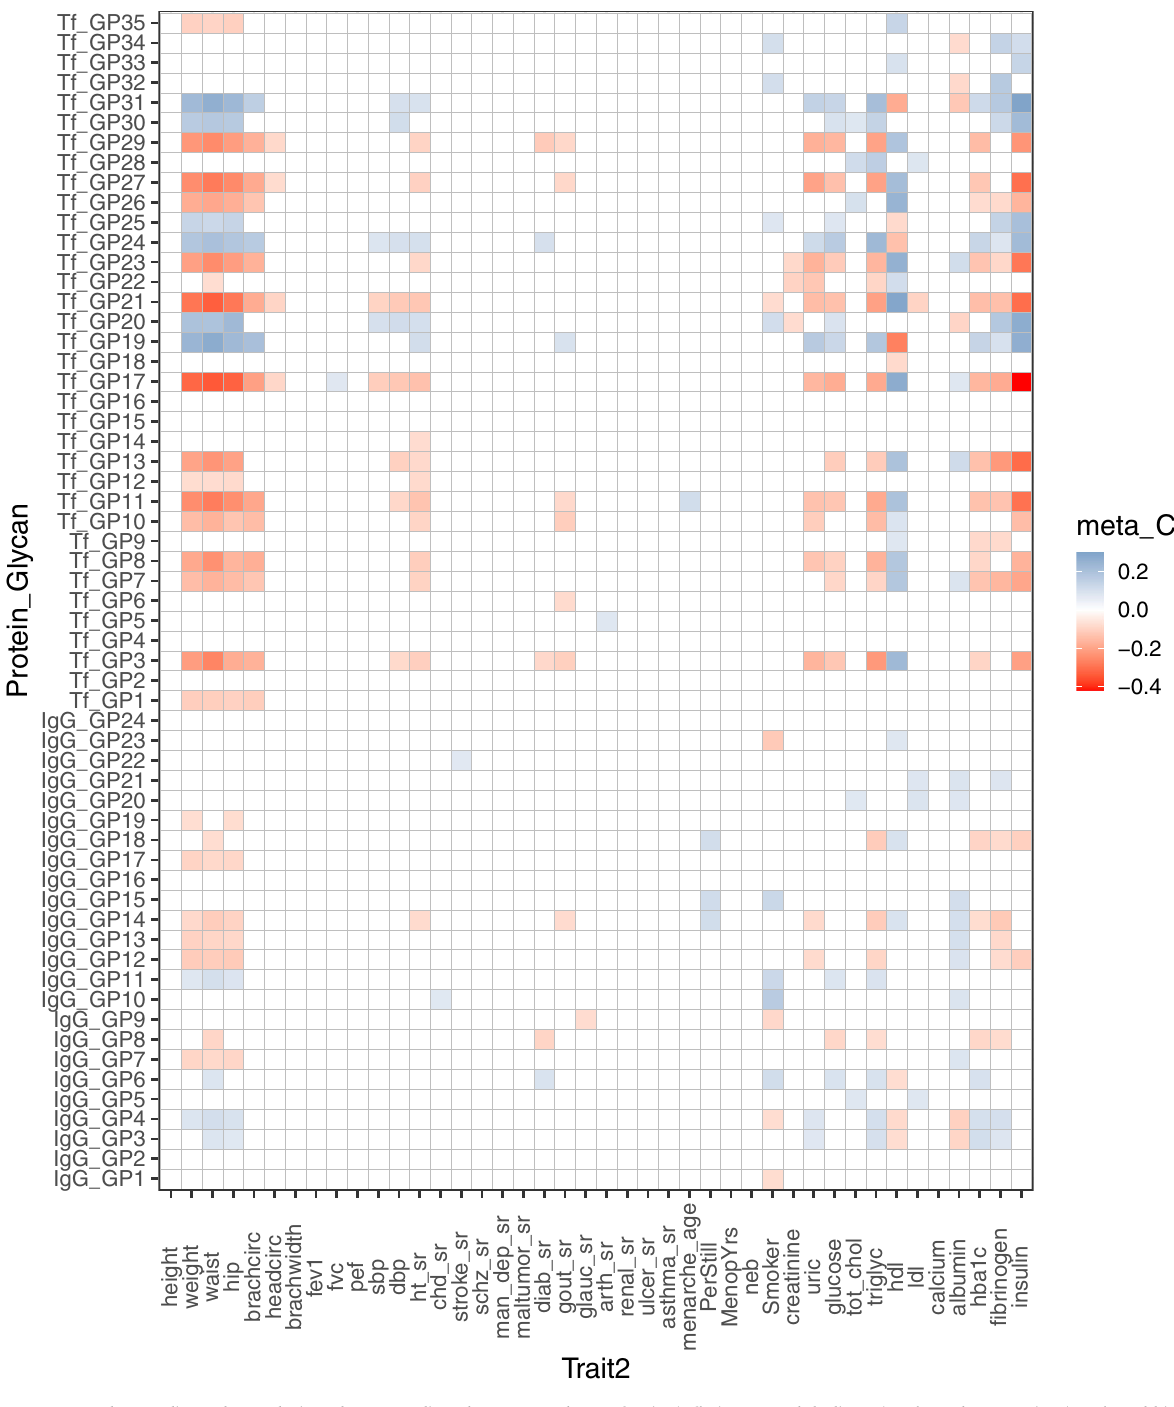
Fig. 4 Age- and sex-adjusted correlations between directly measured transferrin (Tf)/immunoglobulin G (IgG) N-glycan traits (GPs) and biochemical and physiological traits. Correlation analysis was performed on Korcula and VIKING cohorts separately and then combined using an inverse-variance weighted meta-analysis approach. Prior to correlation analysis, glycan measurements were adjusted for age and sex. Only statistically signi fi cant (adjusted meta p -value < 0.01, method = Benjamini – Hochberg) meta-correlations are shown, where the blue color indicates a positive correlation, and the red color indicates a negative correlation. Description of biochemical and physiological traits is given in Supplementary Table